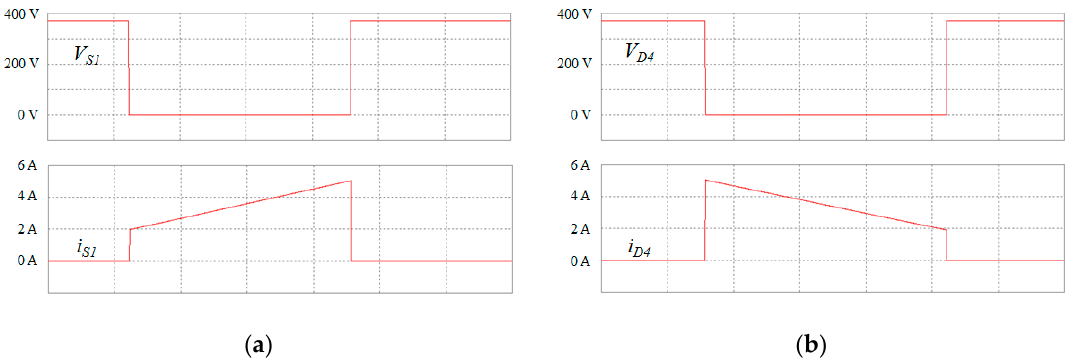
Figure 8. Simulation results of the conventional inverter: ( a ) V S1 and i S1 ; ( b ) V D4 and i D4 .